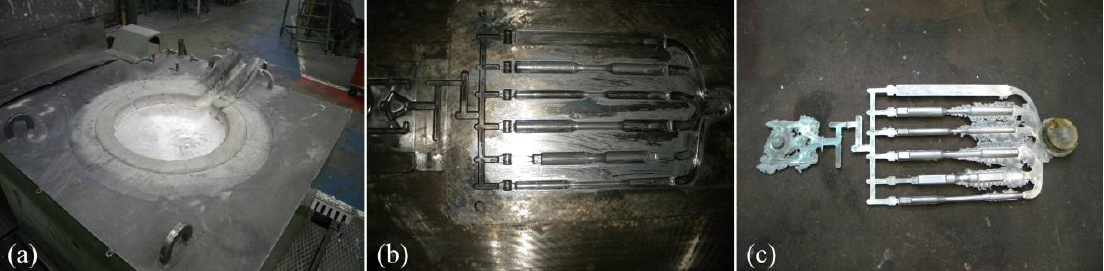
Figure 3. Manufacturing process for specimens made from the AlSi9Cu3 alloy. ( a ) Melt preparation; ( b ) multi-cavity mold-form; ( c ) pressure die casting part.